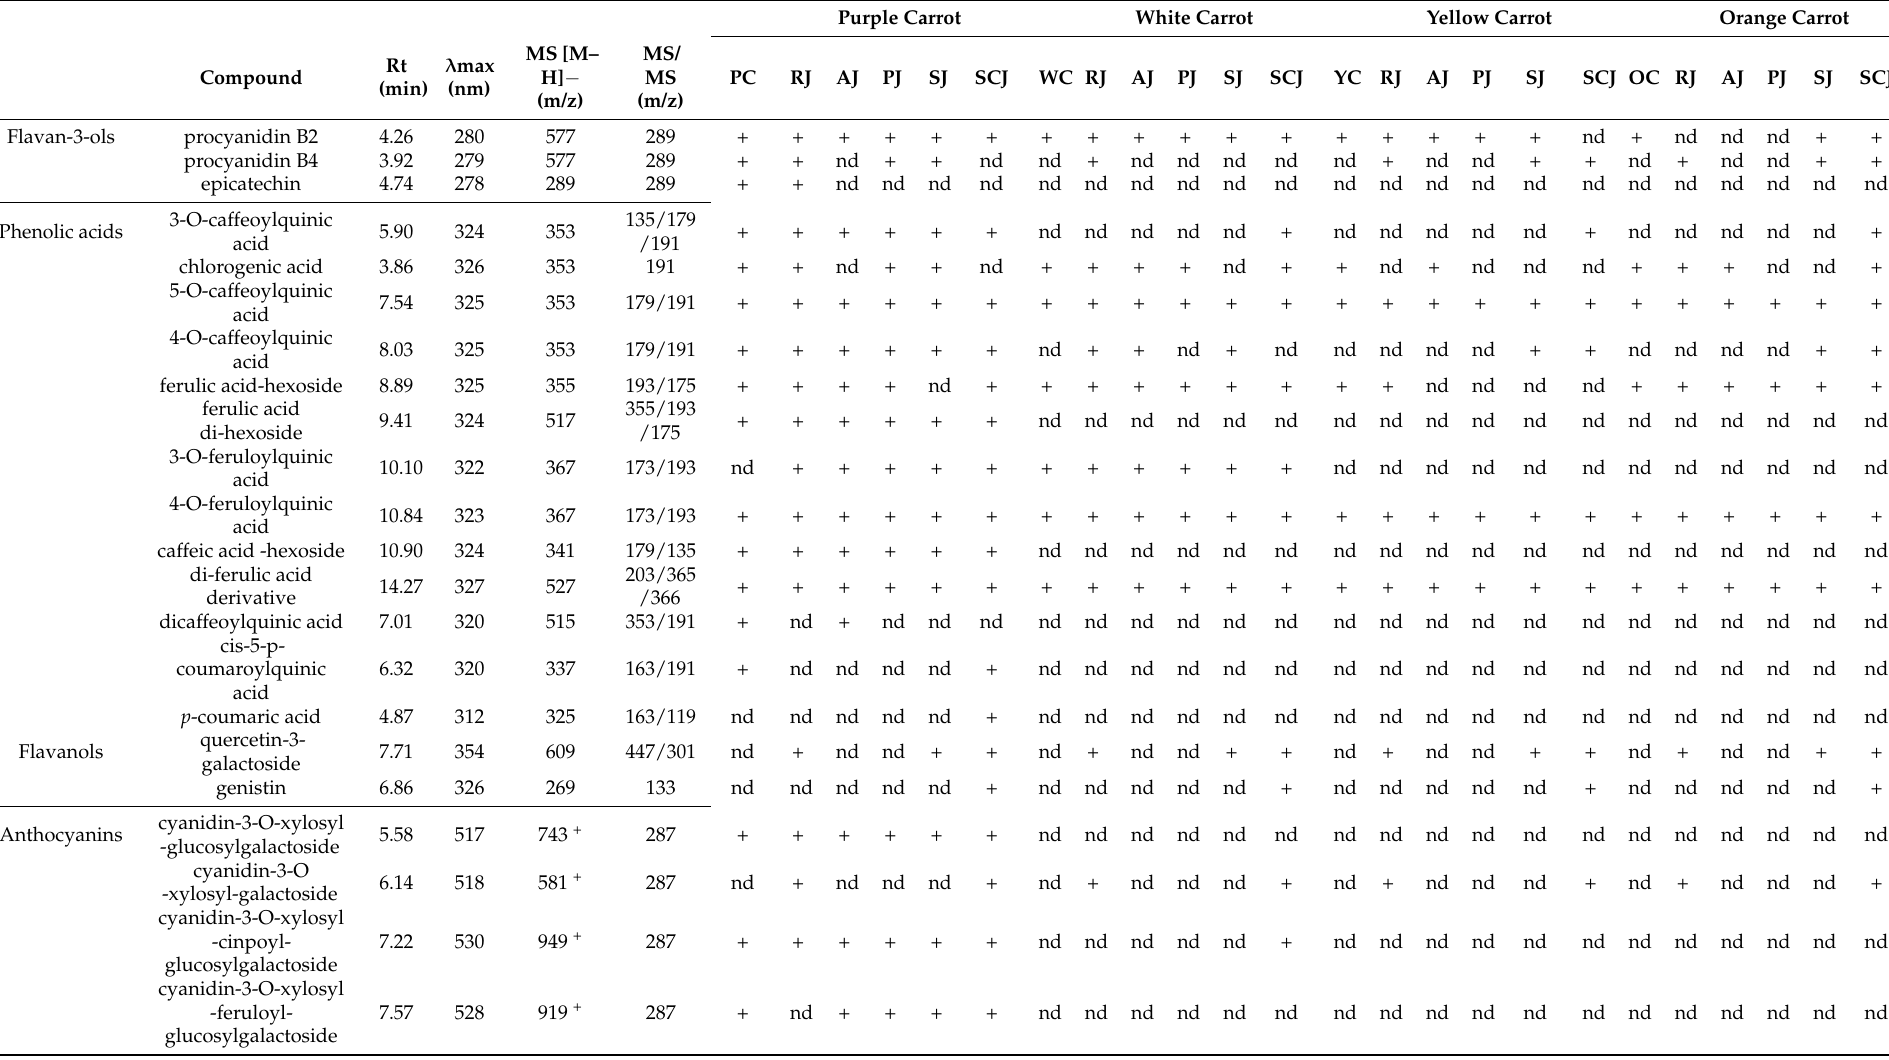
Table 3. Identified polyphenolics by LC/MS in carrot-based smoothies. Purple Carrot White